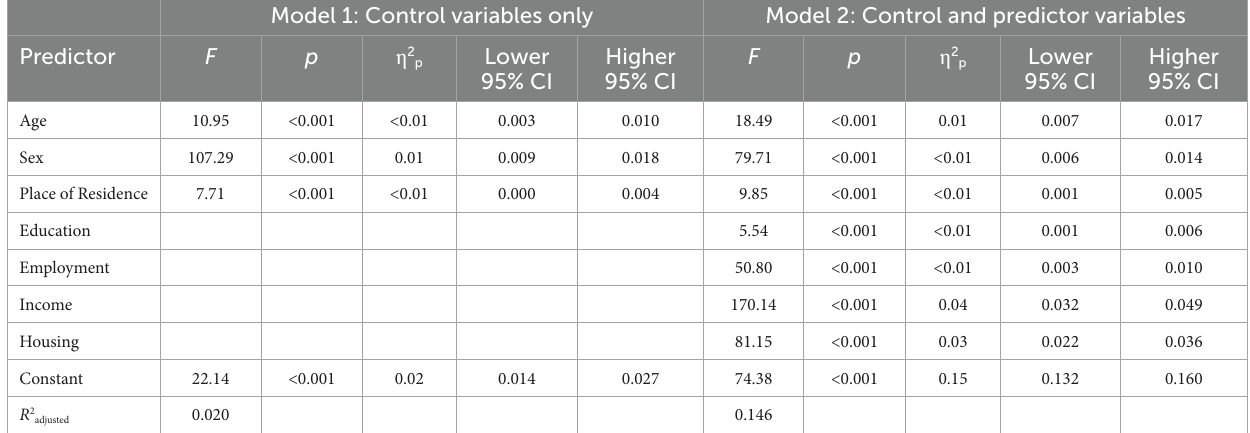
TABLE 3 Predictors of self-reported mental health for First Nations individuals living off-reserve. Model 1: Control variables only Model 2: Control and predictor